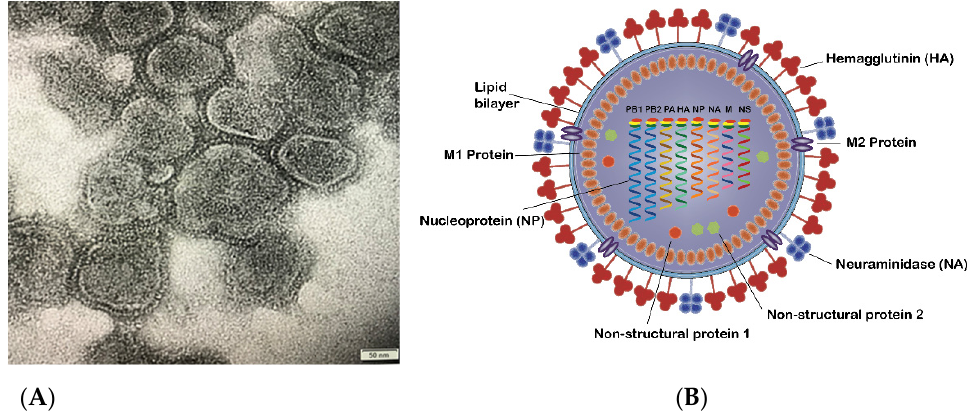
Figure 1. ( A ) TEM image of influenza virus mainly in spherical shapes with particle sizes around 100–150 nm; ( B ) Schematic diagram of an influenza A virus, representing the virus components, including surface glycoproteins HA and NA, M1, and M2 protein, nonstructural proteins, and nu-